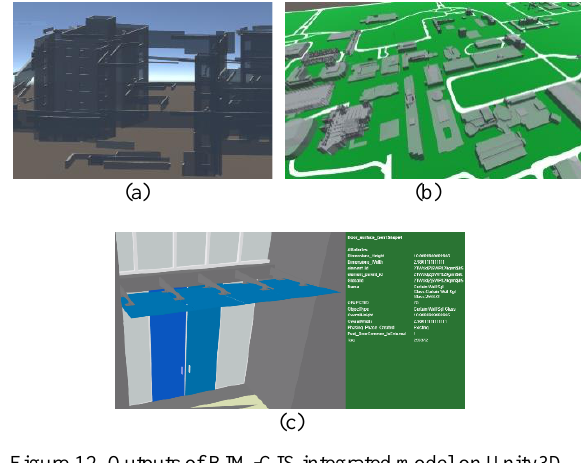
Figure 12. Outputs of BIM-GIS integrated model on Unity3D. (a) Bergeron building only (b) York University campus (c) attributes of Door